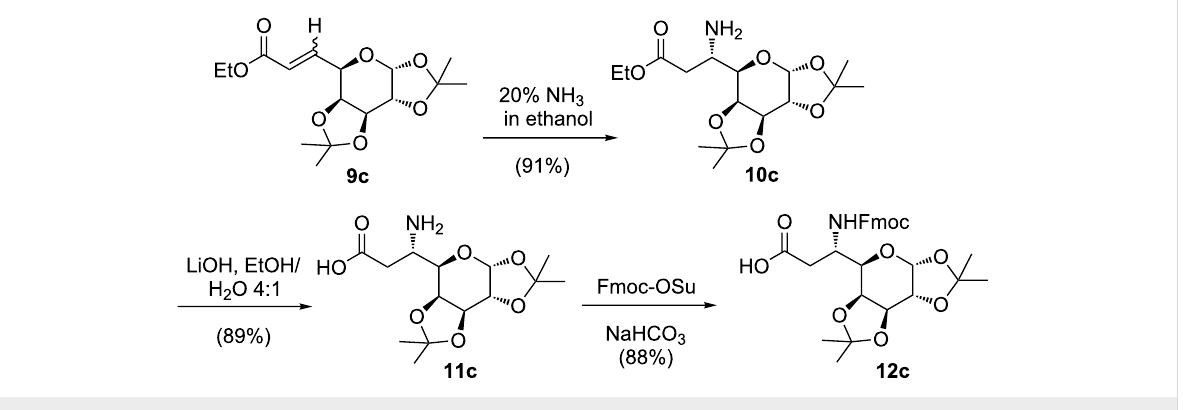
Scheme 2: Synthesis of the galactosyl β -amino acid building block 12c .